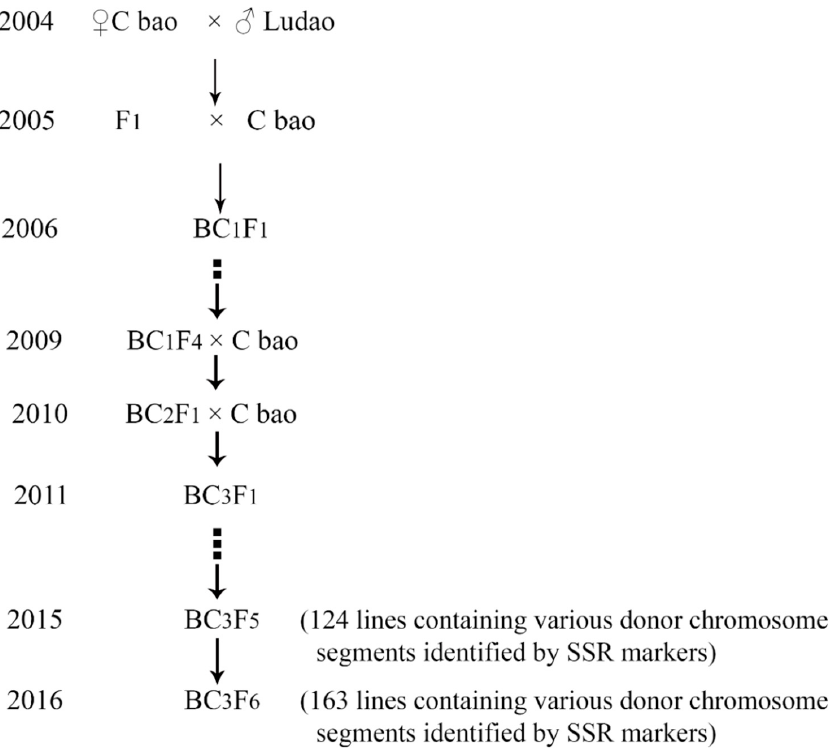
Figure 2. The breeding procedure of the CL-CSSL population used.